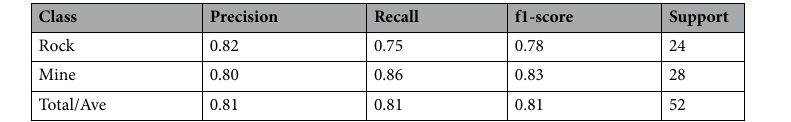
Table 2. The network’s performance is obtained based on the test data corresponding to the imbalanced dataset.